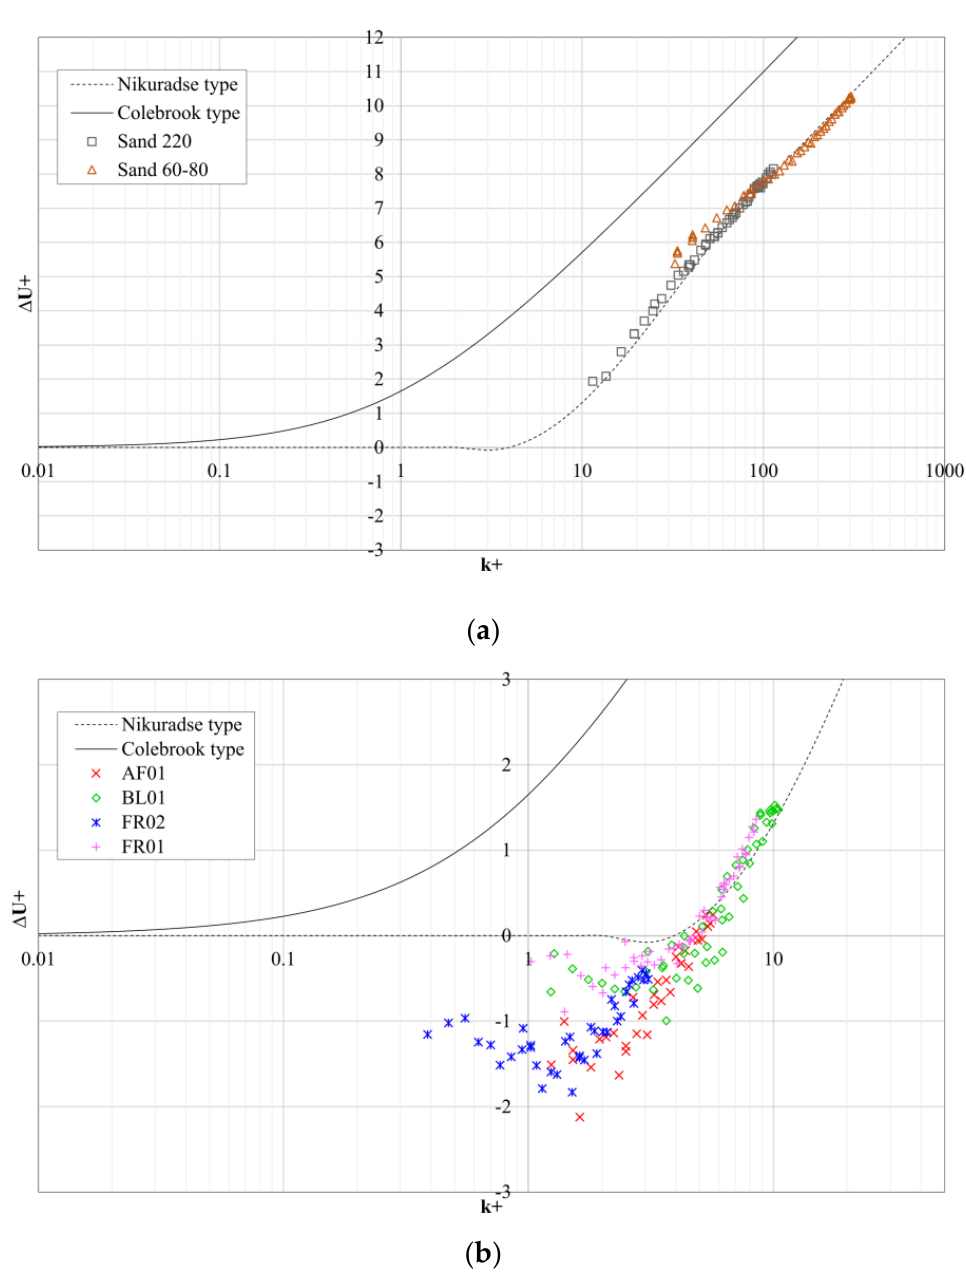
Figure 12. Experimental roughness functions of the test surfaces developed from FTFC pressure drop measurements; ( a ) sanded rough; ( b ) FCCs.